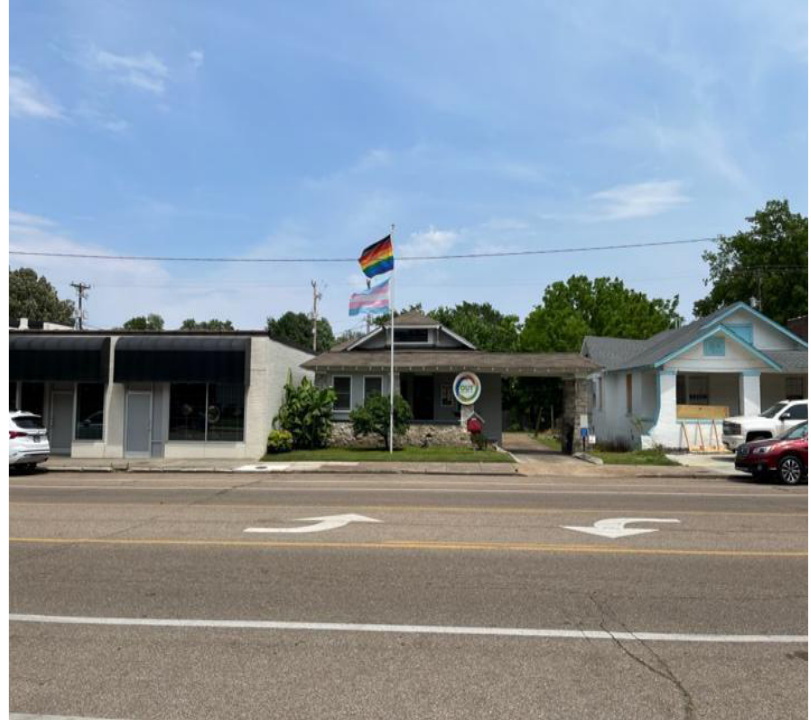
Figure 8. Out Memphis, the most prominent LGBTQ+ organization in the city, occupies a residential building in a middle-class neighborhood. The rainbow flags on its front lawn symbolically mark the building as LGBTQ+ friendly. These overt references to LGBTQ+ space are absent in trans territorialization.